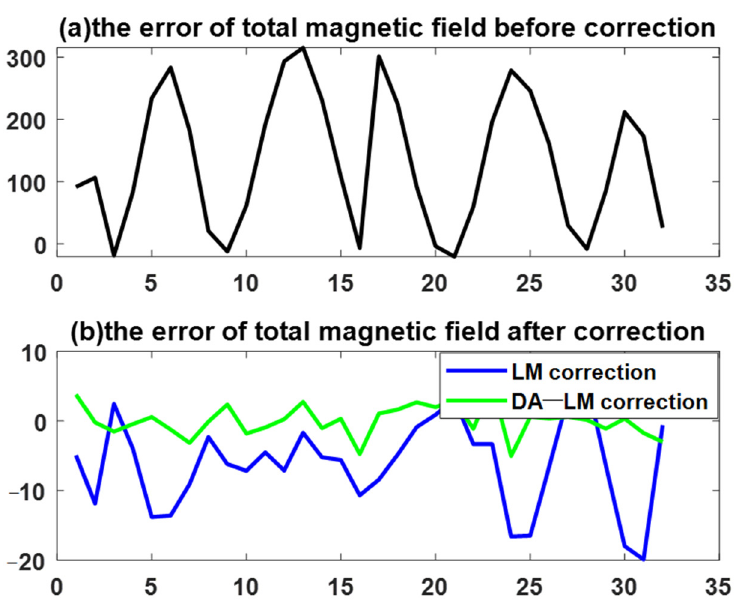
Figure 8. The error of total magnetic field before and after correction. ( a ) The error of total magnetic field before correction; ( b ) The error of total magnetic field after correction, and the blue line represents the LM correction, the green line represents the DA–LM correction. Table 2. The parameters obtained by calculation.